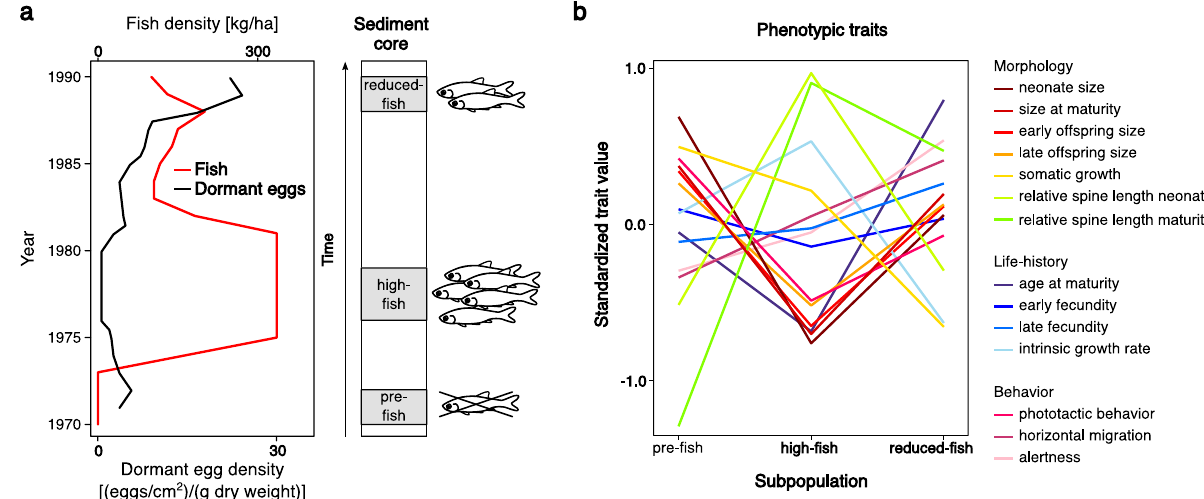
Fig. 1 Resurrection ecology setting and trait change of Daphnia magna subpopulations separated by time in Oud-Heverlee Zuid (OHZ) pond, Belgium. a Numbers of dormant eggs in relation to fi sh-stocking densities throughout the history of the pond (based on data from 10 ). A schematic sediment core marks the time window of the “ pre- fi sh period ” (1970 – 1972), “ high- fi sh period ” (1976 – 1979), and “ reduced- fi sh period ” (1988 – 1990) temporal subpopulations. b Trait change across the three time periods for 14 morphological, behavioral and life-history traits, 10 of which showed a partial reversal in trait change when fi sh predation was relaxed and four of which changed in the same direction during the two transition periods (data from 9 ). For clarity, error bars are not depicted (see 9 for more detail), but signi fi cant genetic changes in trait value were observed for all traits, except early fecundity. The observed genetic trait changes were in line with expectations under the assumption of adaptive evolution, suggesting that this population underwent a rapid (6- and 10-year time span) adaptive evolution in response to a strong increase and subsequent relaxation of fi sh predation pressure 9 .